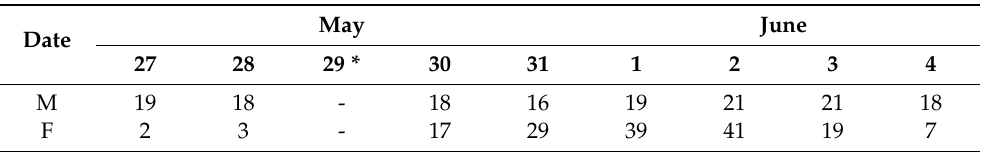
Table 1. Number of individuals in the spawning ground at